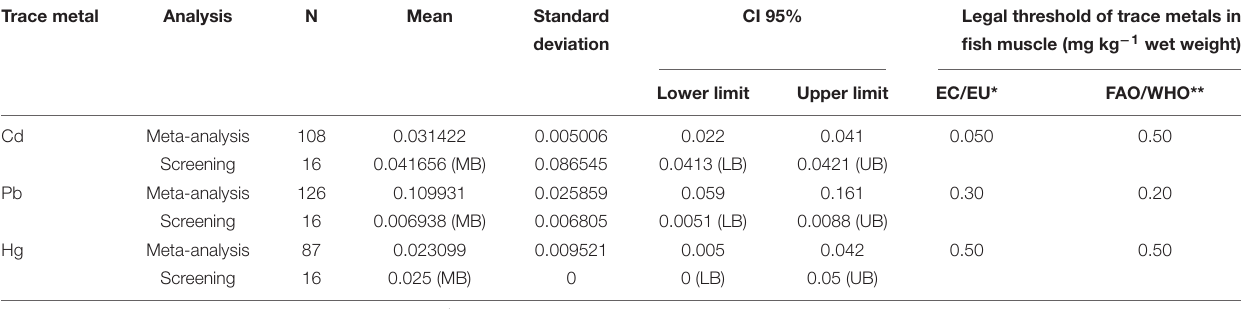
TABLE 2 | Concentrations of trace metals (Cd, Pb, and Hg) in muscle tissue of farmed sea bass. Trace metal Analysis